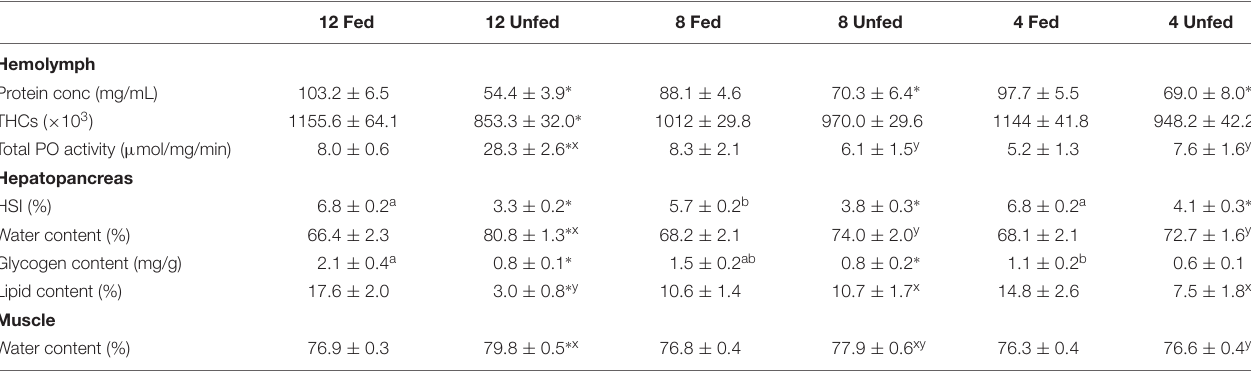
TABLE 3 | Parameters measured in the hemolymph, hepatopancreas and muscle of H. gammarus fed and unfed kept at different holding temperatures (4, 8, 12 ◦ C) after being held in captivity for 24 weeks included in the PCA. 12 Fed 12 Unfed